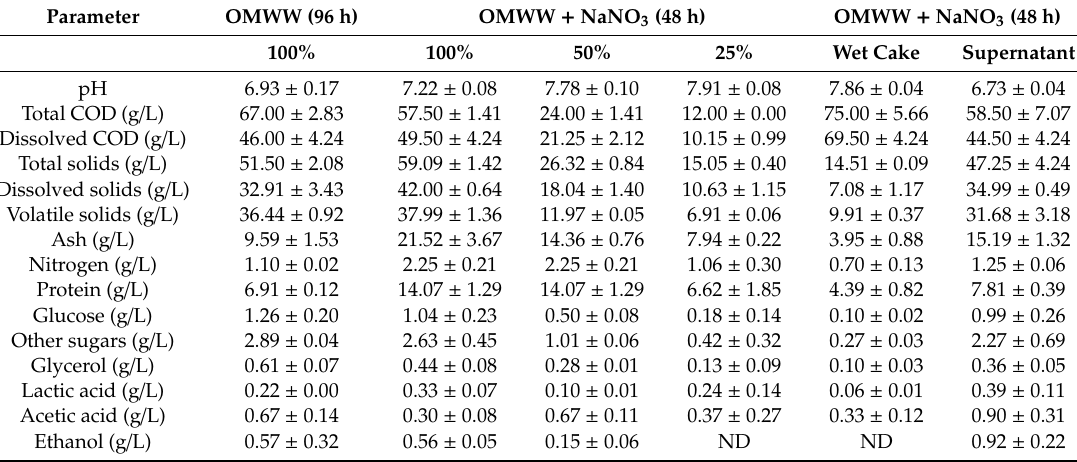
Table 2. Characterization of the remaining streams following cultivation of A. oryzae and biomass separation. The conditions presented are the same as presented in Figure